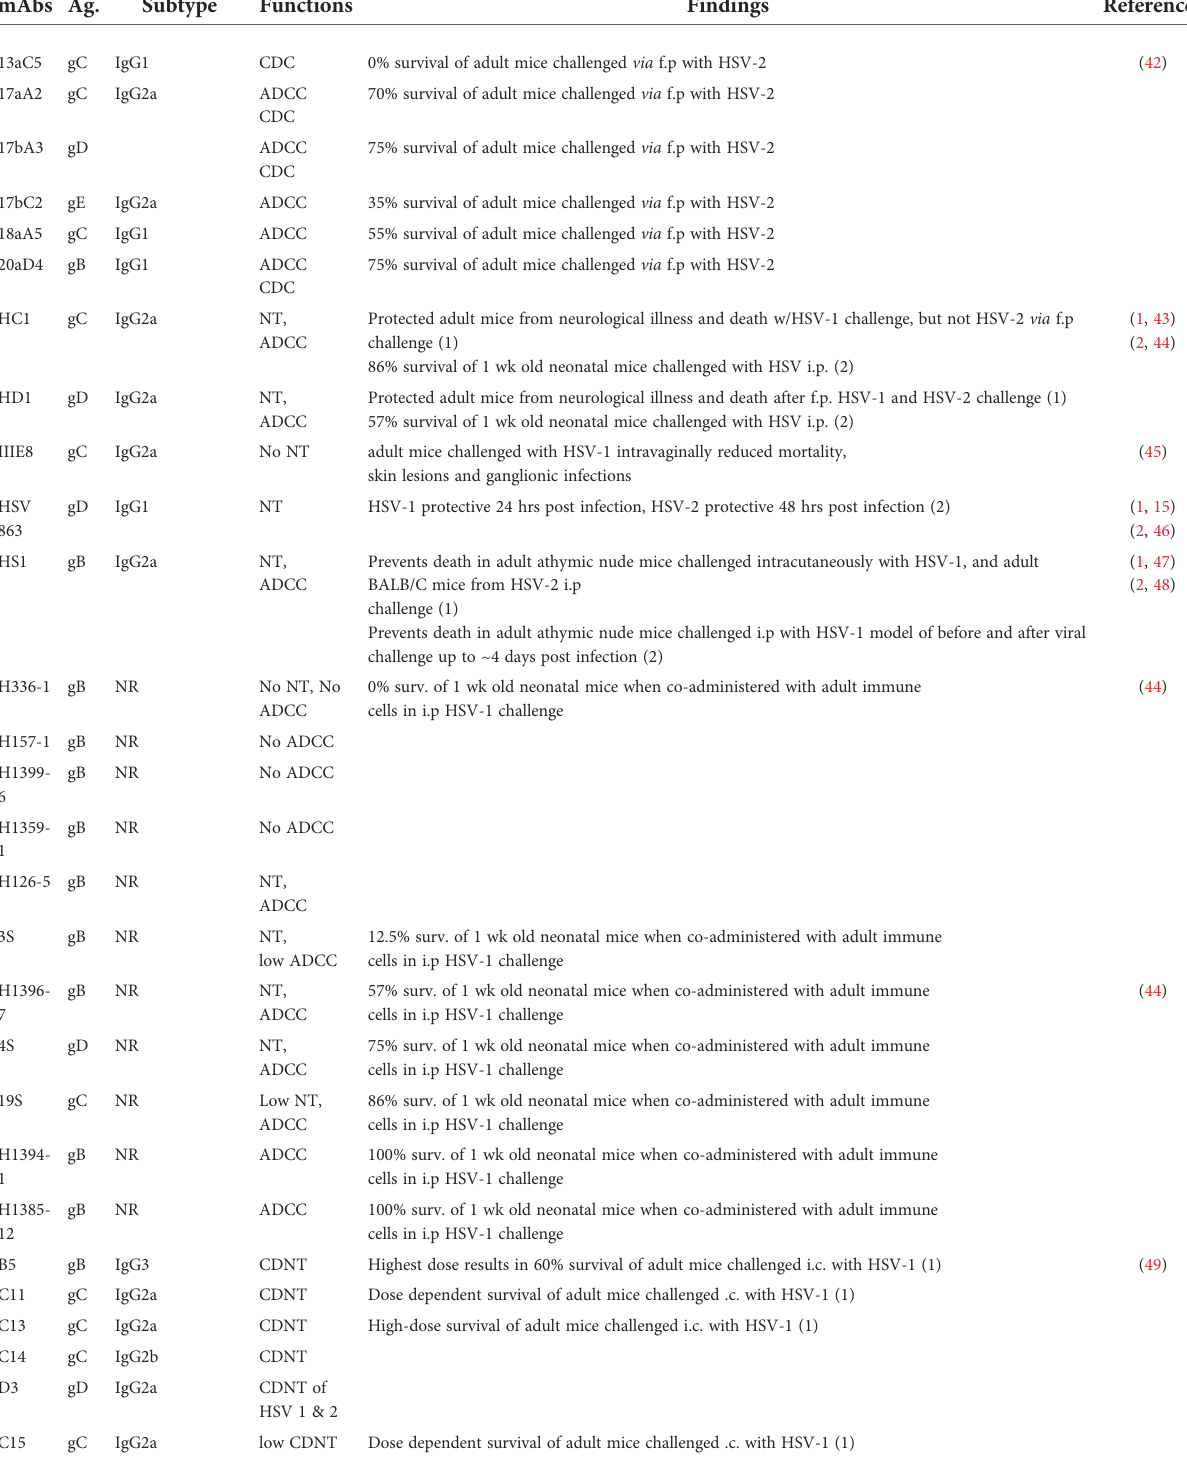
TABLE 1 Summary of studies investigating the role of antibodies in herpes simplex virus infection. . mAbs